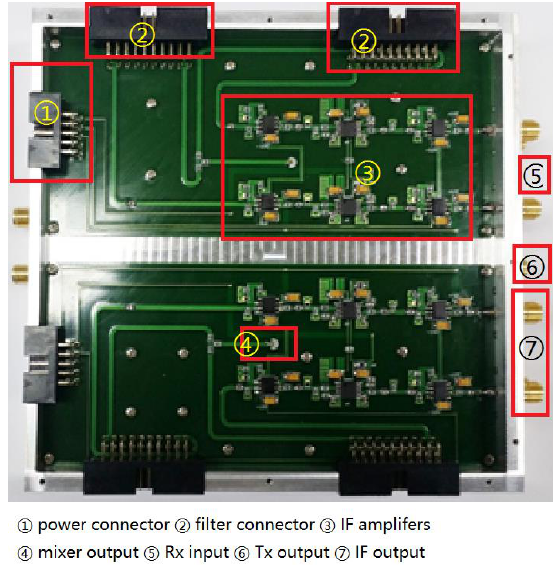
Figure 9. Inward appearance of implemented S-band FMCW TWRI radar system.